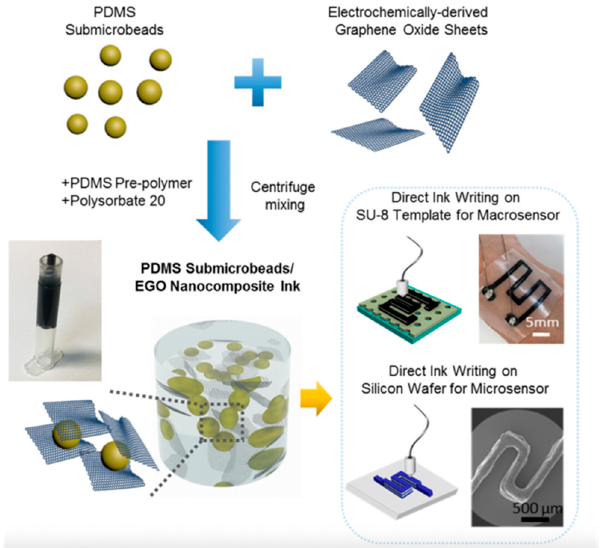
Figure 6. Schematic fabrication of PDMS sub-microbead/EGO nanocomposite ink and 3D direct ink writings wearable micro-sensor and micro-sensor. Adapted from ref. [112]. 2019, Elsevier©.